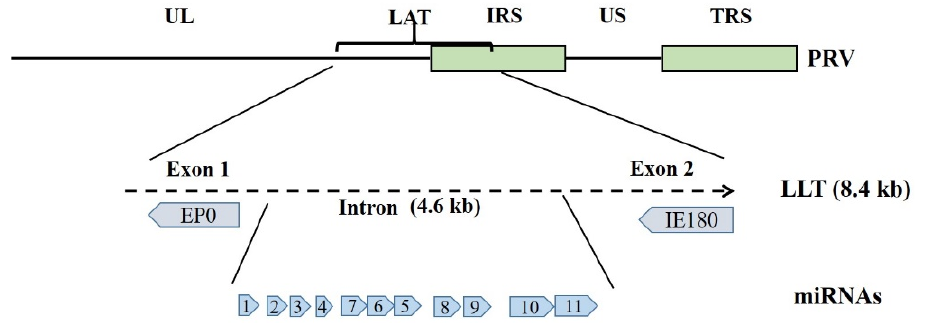
Figure 1. Map of the PRV genome containing unique long (UL), unique short (US), LAT and in- verted repeat (IRS and TRS) sequences. The positions of LLT, EP0 , IE180 , and miRNAs are anno- tated,